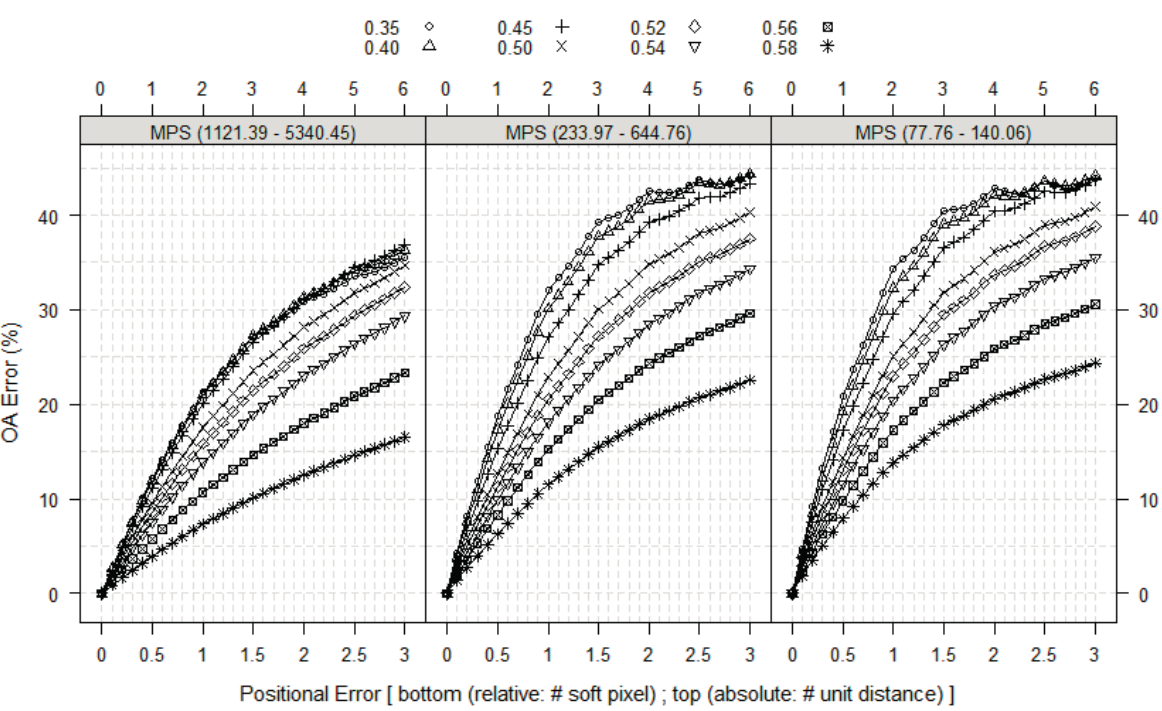
Figure 3. Impact of positional error on OA-error at different landscape characteristics using a spatial resolution of 1 unit distance.